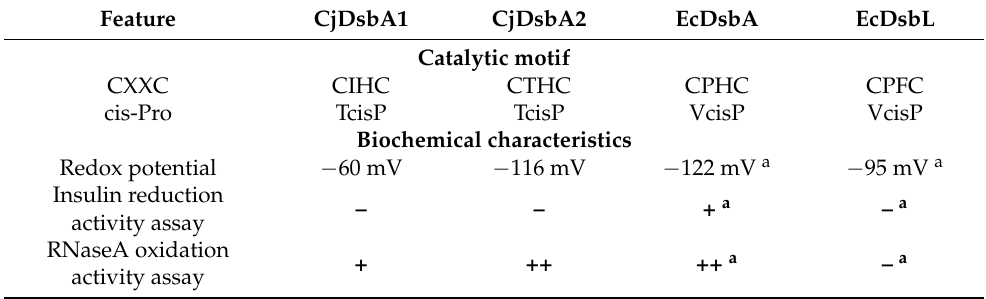
Insulin reduction activity